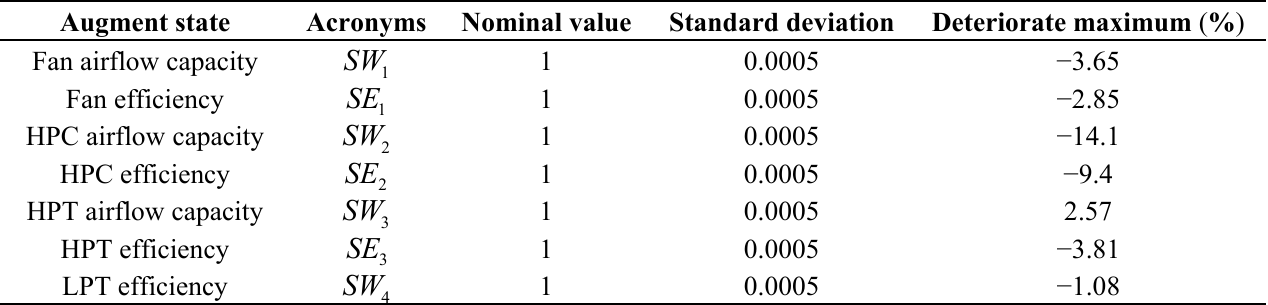
Table 2. CLM turbofan model health parameter, nominal value, standard deviation and degeneration